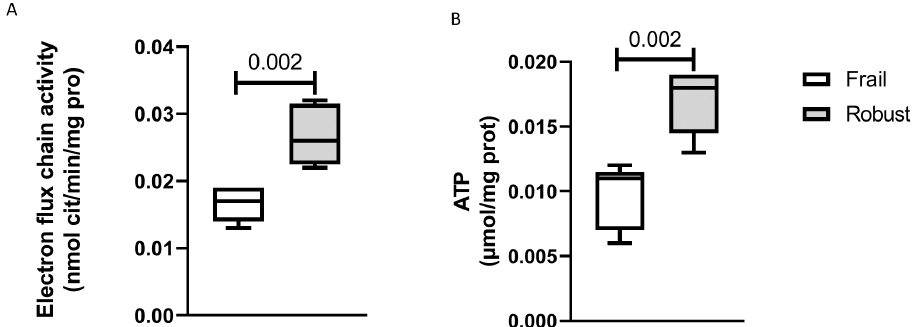
Figure 3. Mitochondrial activity in PBMCs from frail and robust older subjects. Panel ( A ) The box and whisker plot shows electron flux chain activity (on the y-axis) in mitochondria from frail and robust subjects. Panel ( B ) The box and whisker plot shows the ATP levels (on the y-axis) in mitochondria from frail and robust subjects. Box and whiskers are drawn according to the Tukey method; median and interquartile range maximum and minimum values are shown. p -values were calculated by one-way ANOVA.